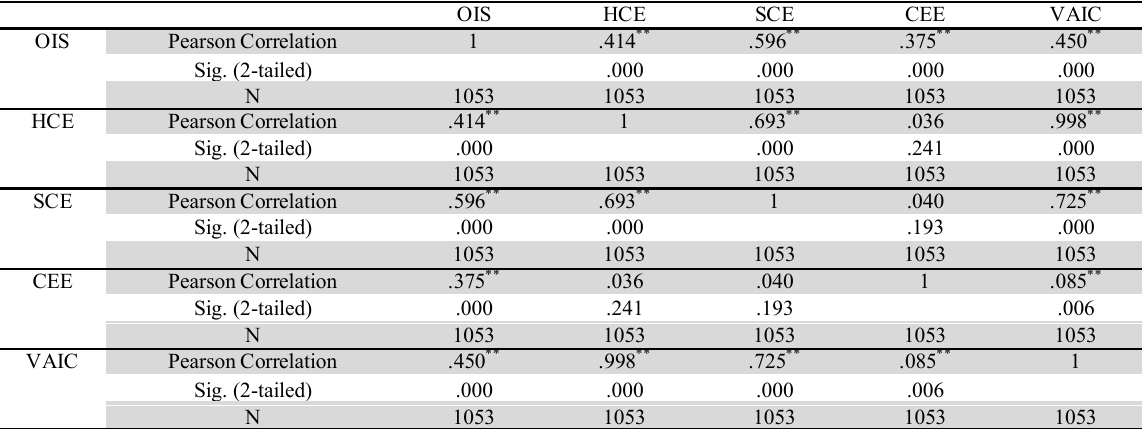
The summary of Pearson correlation